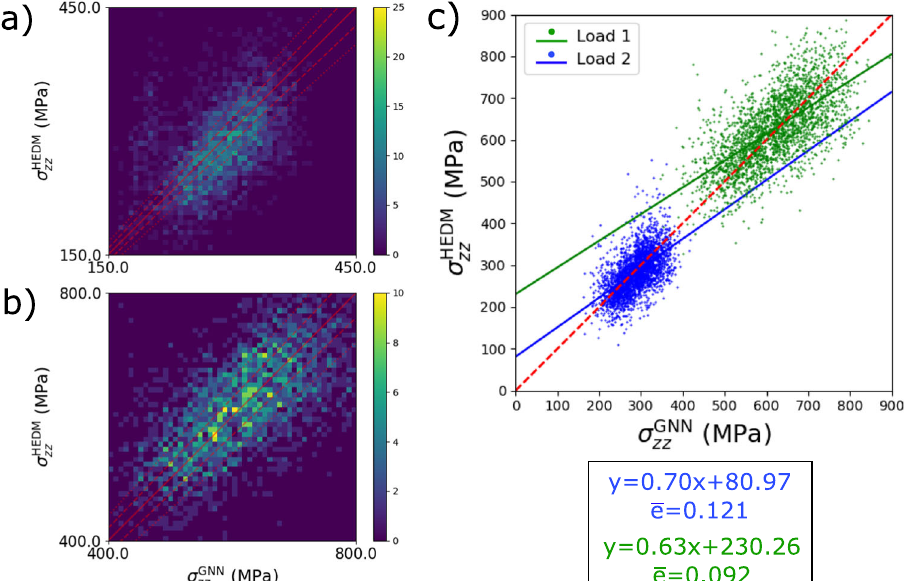
Fig. 5 Comparisons of stress predictions along the loading direction ( σ zz ) from GNN surrogate models using lattice orientation as nodal features with those measured using ff-HEDM during in situ elastic loading for LSHR. Histograms of comparisons at a Load 1 (applied strain of 0.0015) and b Load 2 (applied strain of 0.0033). c Scatter plot comparing GNN predictions and ff-HEDM results from the two load steps along with regression lines fi t the comparisons.